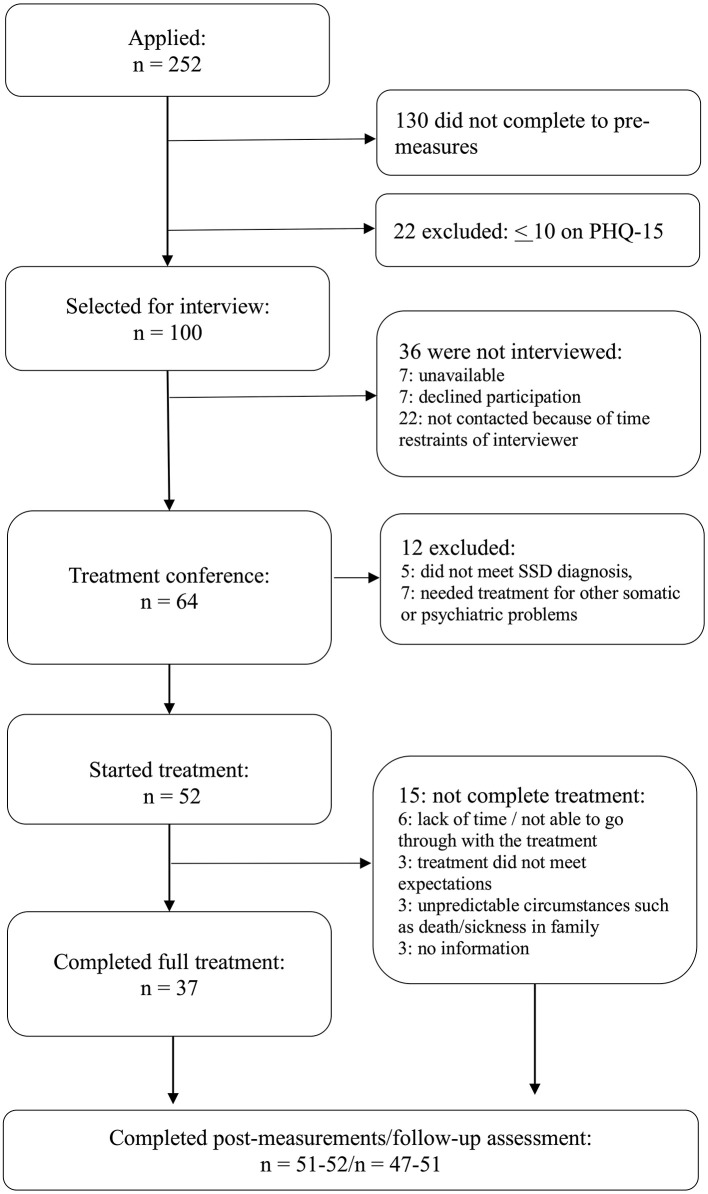
Study flowchart.